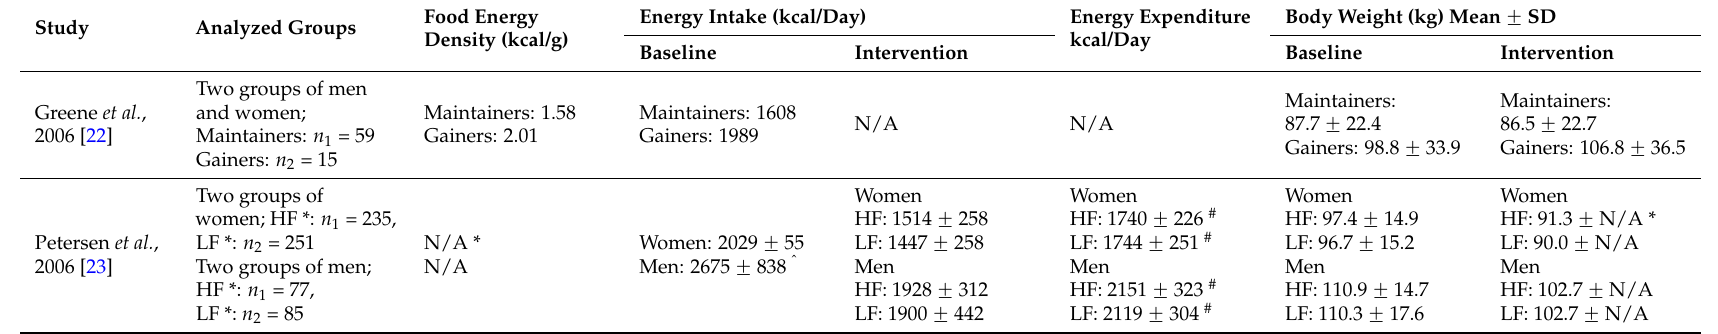
Table 2. Mean changes in body weight taking into consideration food energy density and energy intake in selected studies (results for